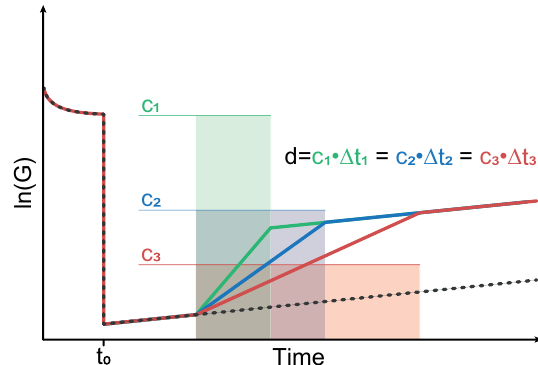
Figure 2. Schematic conductance curve with a temperature jump from high to low temperature; during the relaxation at the low tem- perature stage, three peaks with different peak width and the same gas dosage are